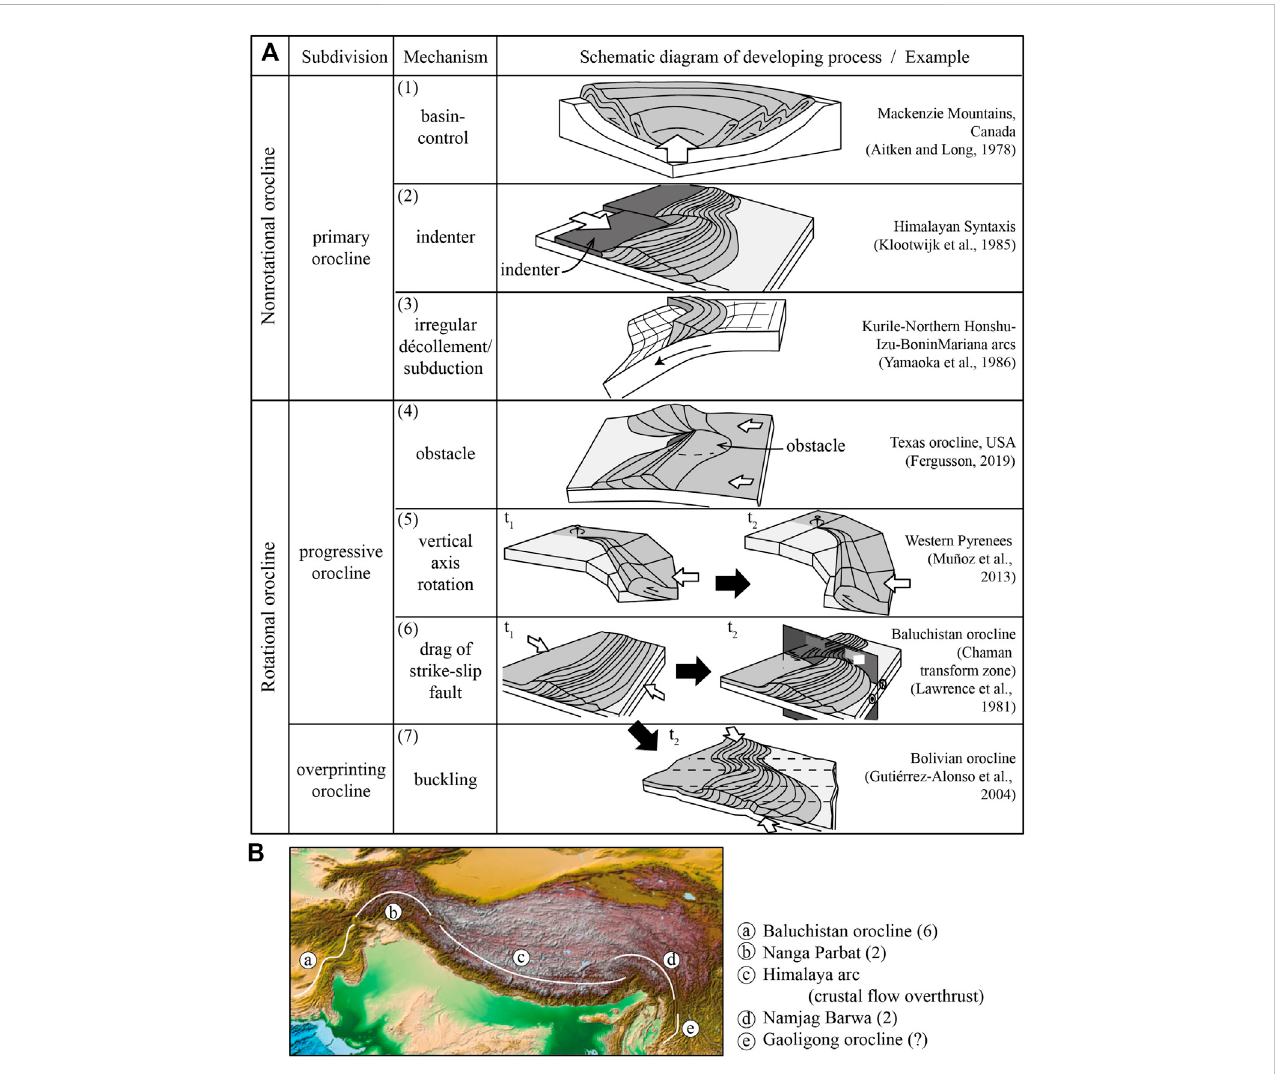
FIGURE 1 (A) Schematic diagrams showing different forming mechanisms and corresponding examples of oroclines. The 3D sketches are modi fi ed from Marshak (2005),Hwangetal.(2012),Muñozetal.(2013),andBersanetal.(2017). (B) ETOPO1digitalreliefmaparoundtheIndia – Eurasiacollisionzone,showingvarious orocline systems (https://ngdc.noaa.gov/mgg/global/global.html). The numbers mark the type and mechanism that were proposed for its formation by previous studies. No forming mechanism had been proposed for the Gaoligong orocline, from all the orocline